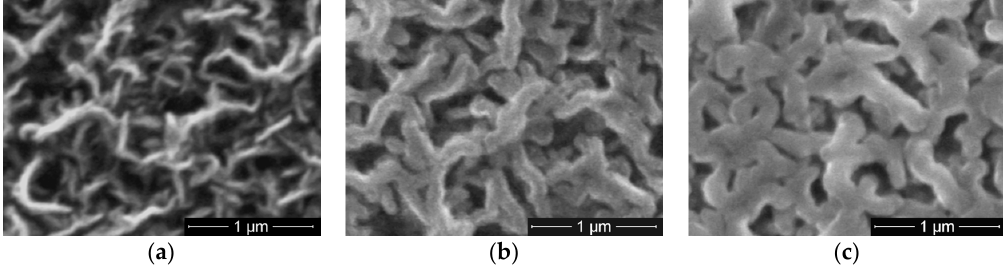
Figure 8. SEM images of CNW treated with C 2 H 2 F 4 plasma for ( a ) 2 sccm; ( b ) 8 sccm; and ( c ) 36 sccm.